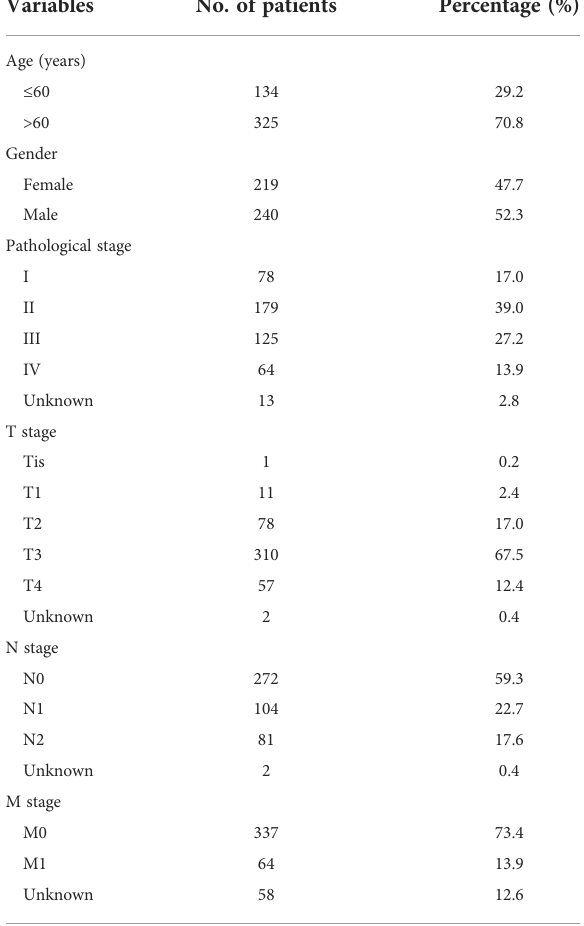
TABLE 1 Clinical information of COAD patients in the TCGA database.